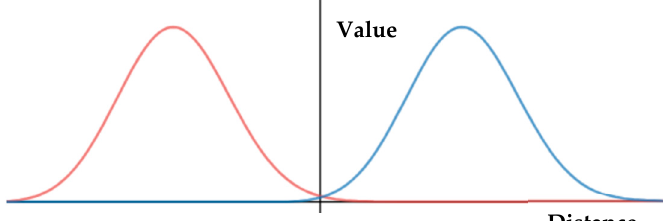
Figure 8. Differentiated reliability function; the x-axis is the distance of the opponent vehicle from the ego vehicle. The y-axis represents the reliability of the value.